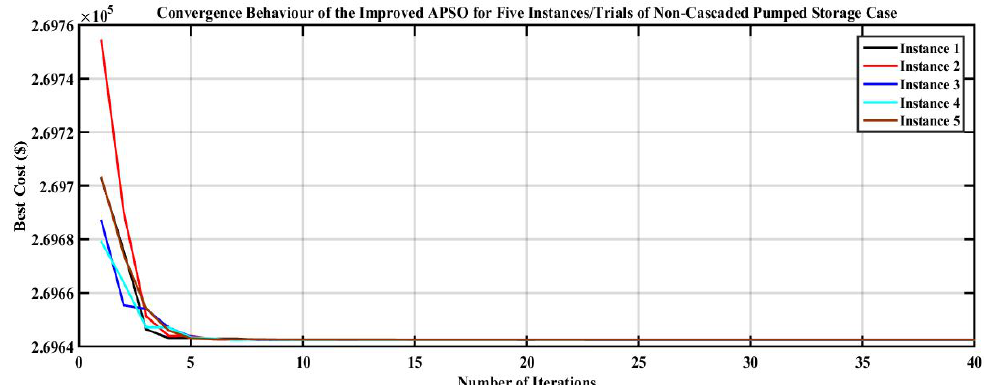
Figure 5. Convergence characteristics of the improved APSO algorithm on the non-cascaded pumped STHTS problem for five different